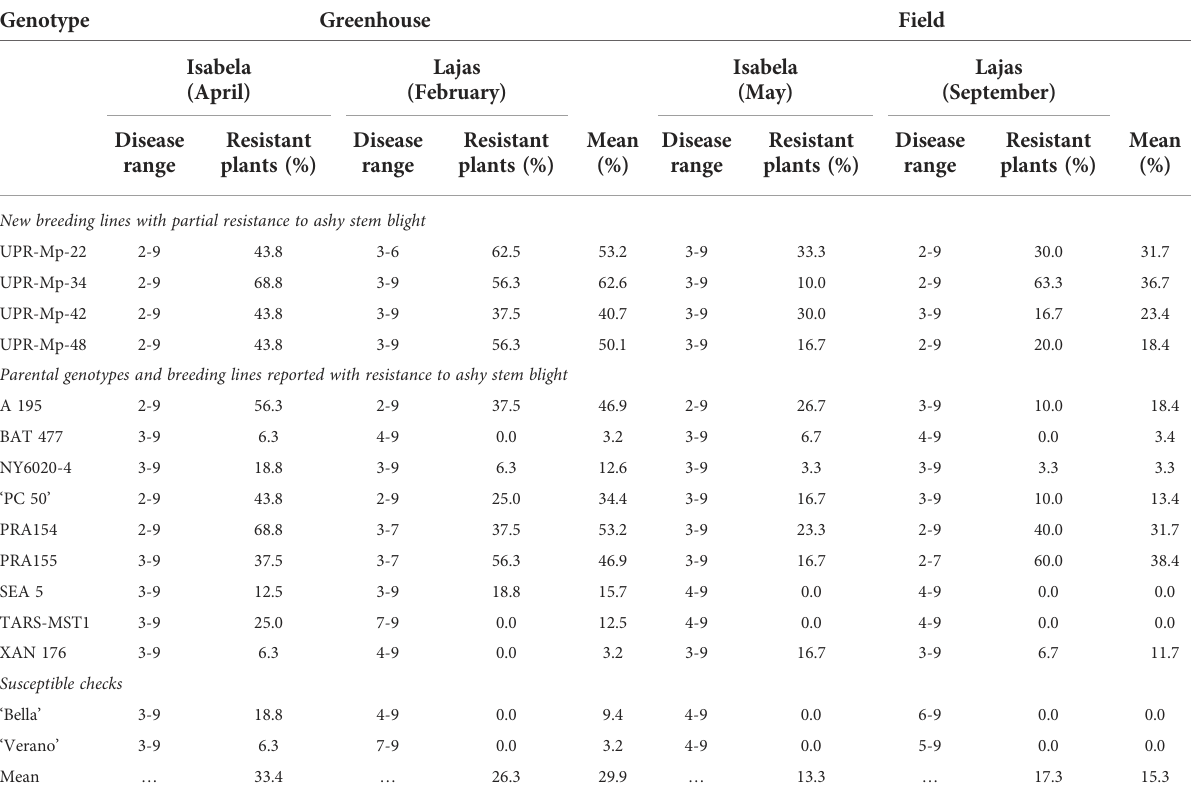
TABLE 2 Disease range and percentages of ashy stem blight-resistant plants for four pyramided common bean ( Phaseolus vulgaris L.) breeding lines, their parents/known sources of resistance, and susceptible checks evaluated against PRI21 Macrophomina phaseolina (Tassi) Goidanich isolate at 42 and 21 days after inoculation in the greenhouse and the fi eld in Isabela and Lajas, Puerto Rico, in